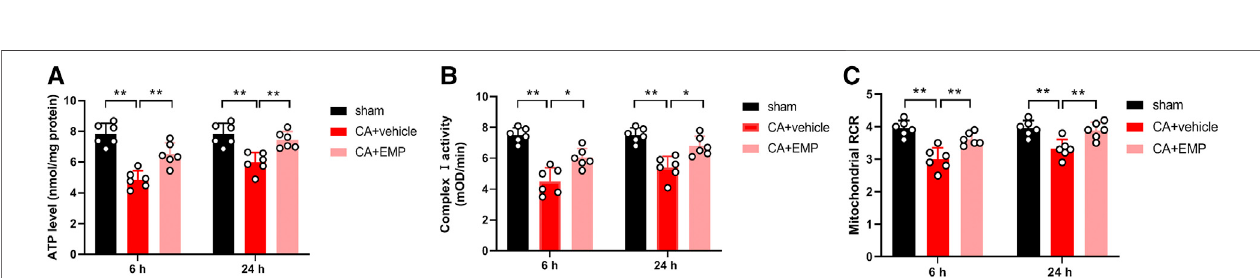
FIGURE6| Empagli fl ozin(EMP) increasedmyocardialenergylevelsand mitochondrialactivity after cardiac arrestinrats. (A) EMPincreasedmyocardialATPlevels at 6 and 24 h after return of spontaneous circulation (ROSC). (B) EMP increased the myocardial mitochondrial complex Ⅰ activity at 6 and 24 h after ROSC. (C) EMP increased the myocardial mitochondrial respiratory control ratio (RCR) at 6 and 24 h after ROSC. Data are presented as mean ± SD, n (cid:1) 6, * p < 0.05, ** p < 0.01.